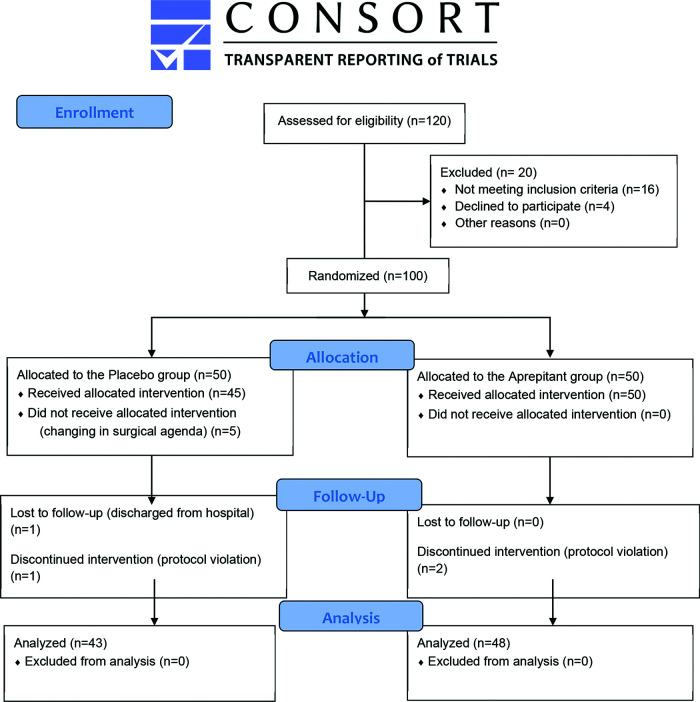
CONSORT 2010 Flow Diagram.